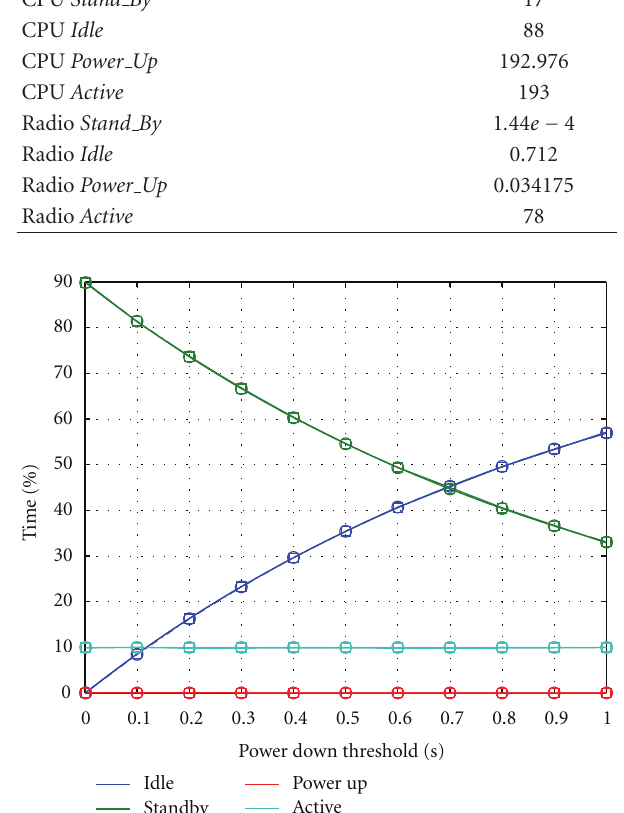
Figure 5: P ow e r Up De lay = 0 . 001